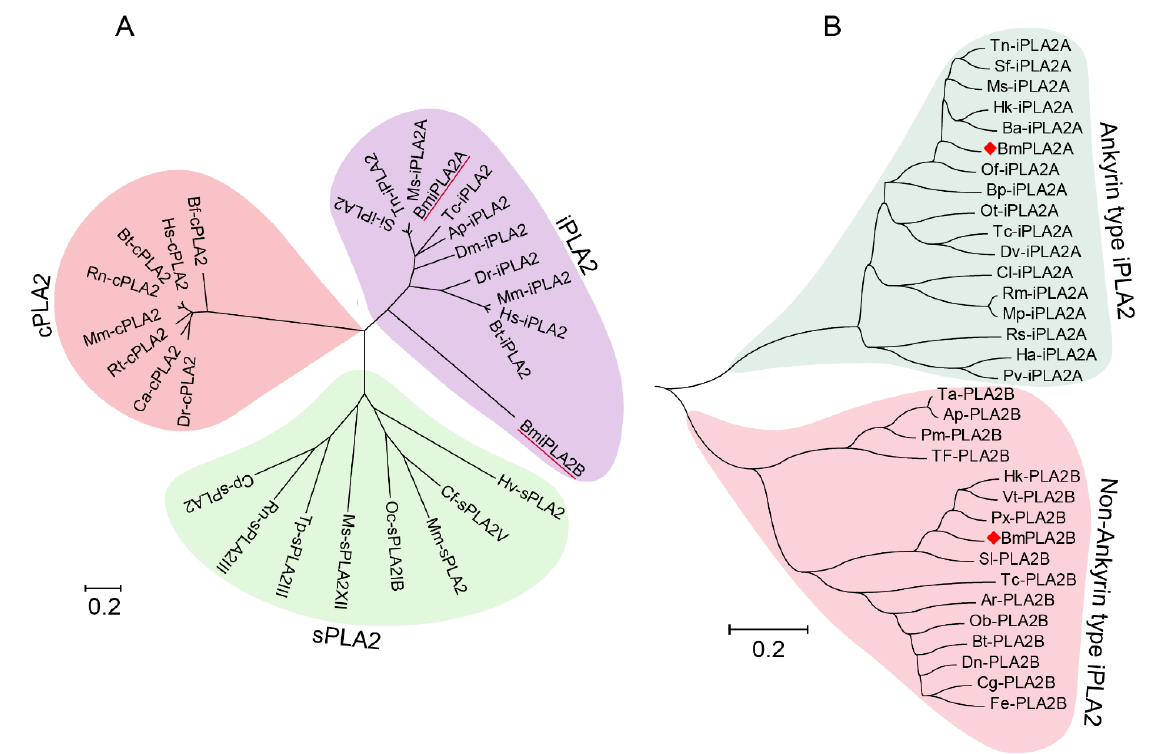
Figure 3. Phylogenetic analysis of BmiPLA2A and BmiPLA2B. ( A ) Phylogenetic analysis of BmiPLA2A and BmiPLA2B (underlined in red) with other iPLA2, cellular PLA2 (cPLA2) and secretory PLA2 (sPLA2) from different species. ( B ) Phylogenetic analysis of two subgroups of insect iPLA2s. BmiPLA2A and BmiPLA2B are labeled with red diamond. The organisms and GenBank acces- sion numbers are listed as follows: Calcium-independent phospholipase A2 from Homo